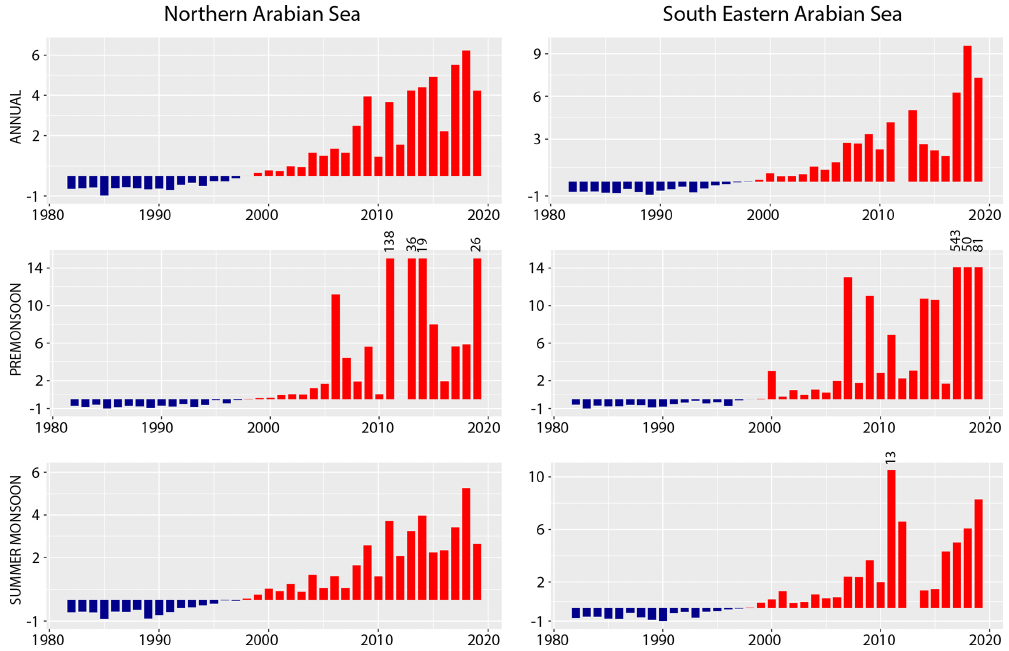
Figure 5. Same as Fig. 2 but using the detrended SST.